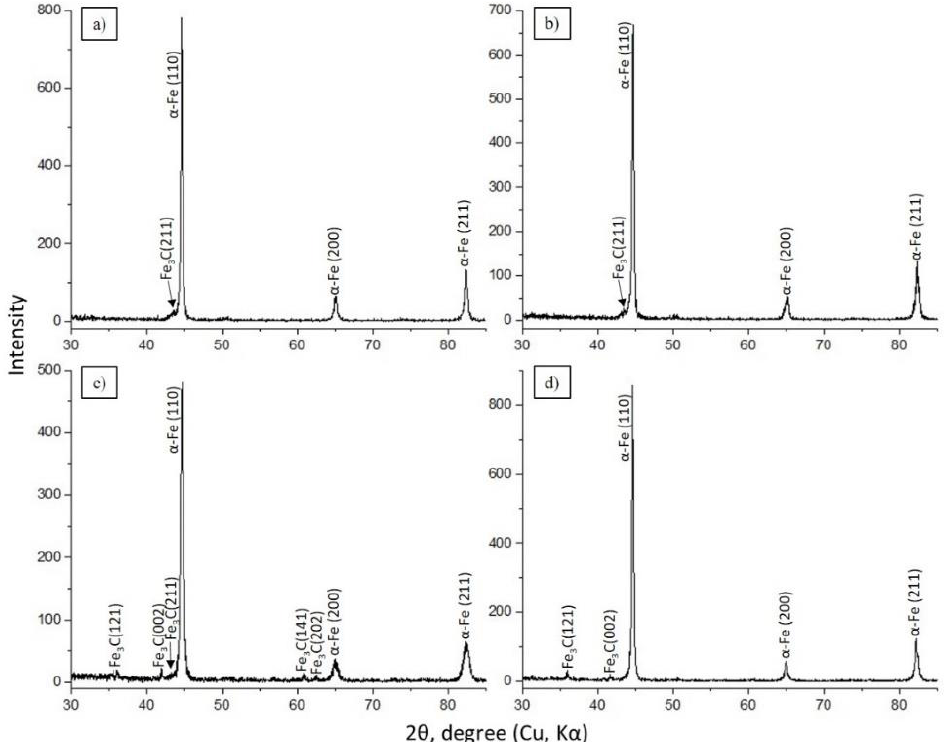
Figure 3. Samples processed according to the modes: ( a ) No. 1; ( b ) No. 2; ( c ) No. 3; and ( d ) No. 4 (Table 1). Diffractogram of 30CrMnSiA steel after EPTCH.